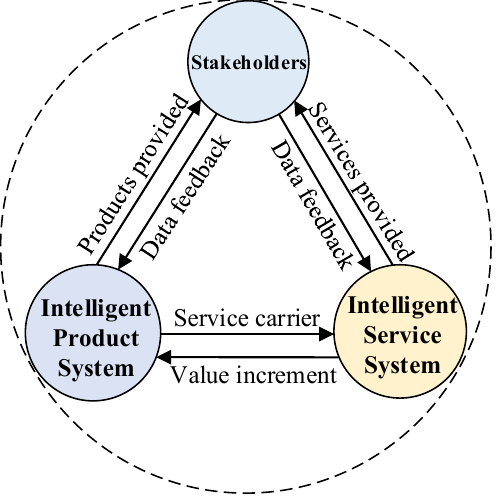
Figure 1. Stakeholders–Intelligent Product–Intelligent Service system.